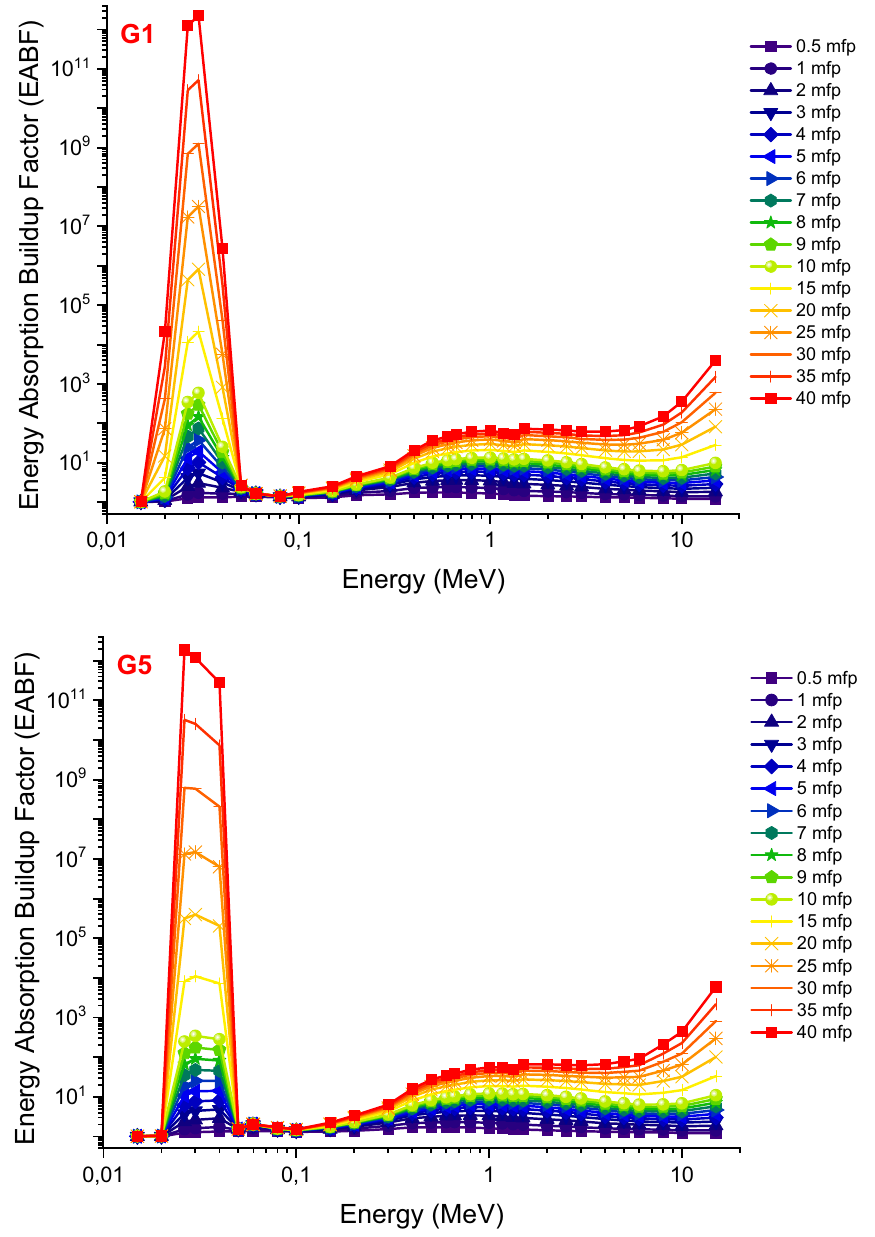
Figure 11: Variation of EABF of G1 and G5 glasses at di ff erent mean free path